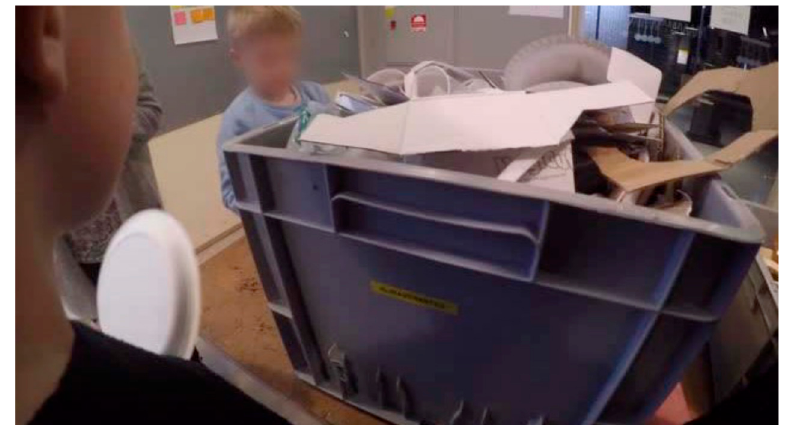
Figure 5. Children making things from recycled materials.